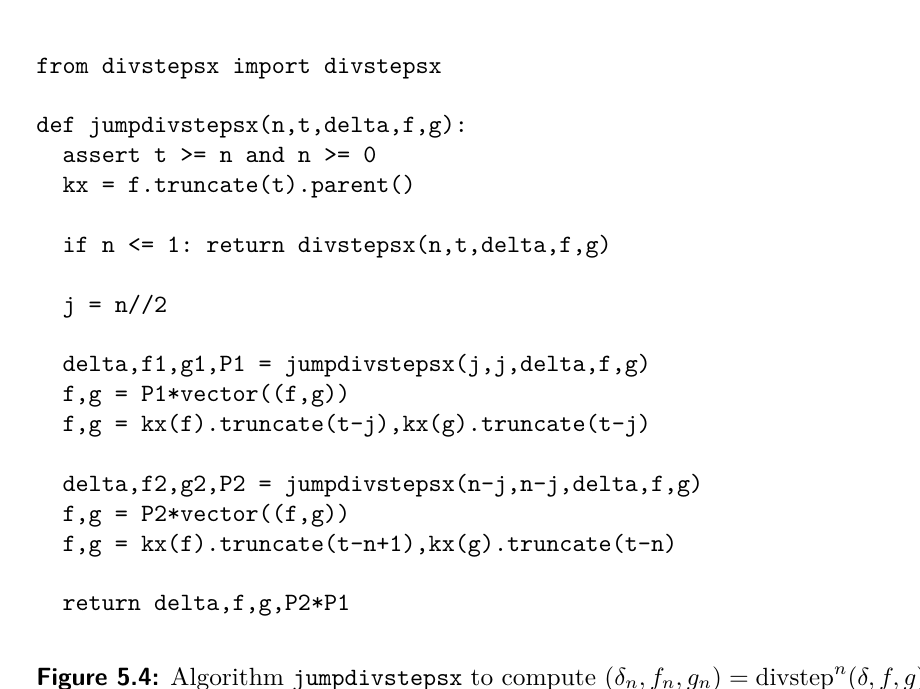
Figure 5.4: Algorithm jumpdivstepsx to compute ( δ n , f n , g n ) = divstep n ( δ, f, g ). Same inputs and outputs as in Figure